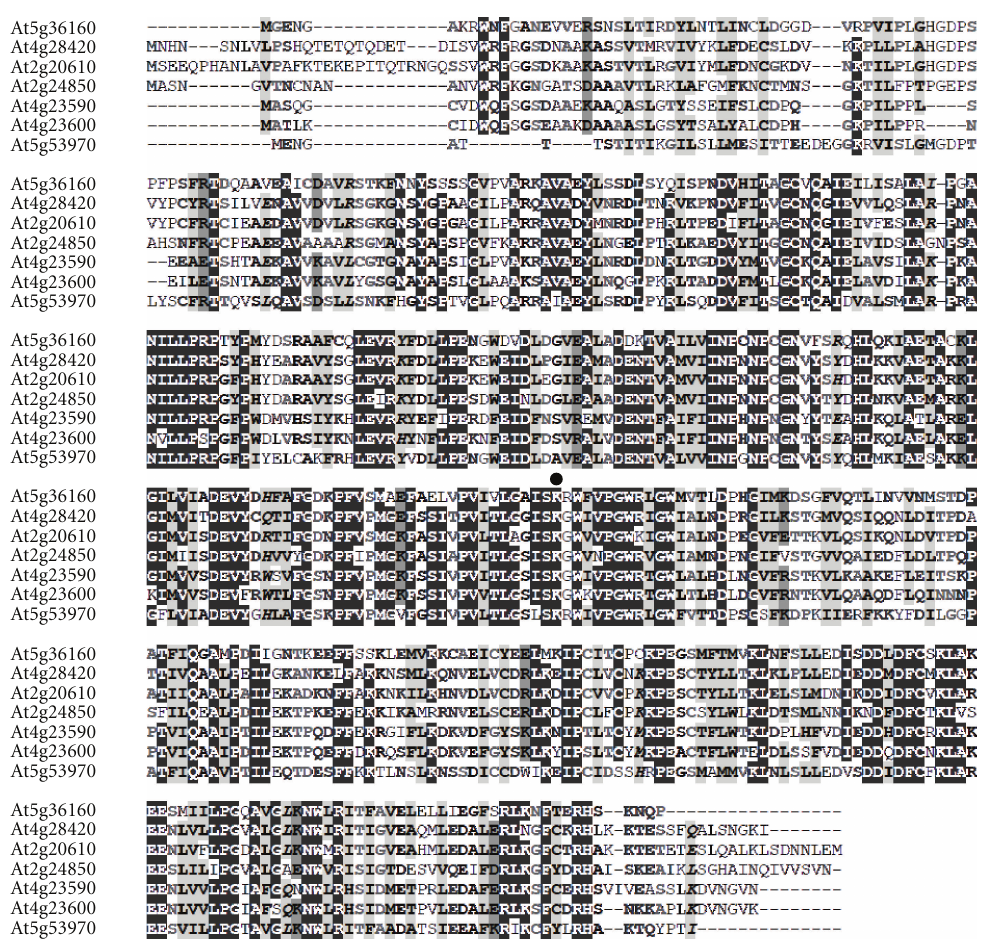
Figure 2: Amino acid sequence alignment of the TAT family from Arabidopsis. The method used for creating the alignment is described in Section 2. The black circle denotes the PLP ligand at the conserved lysine